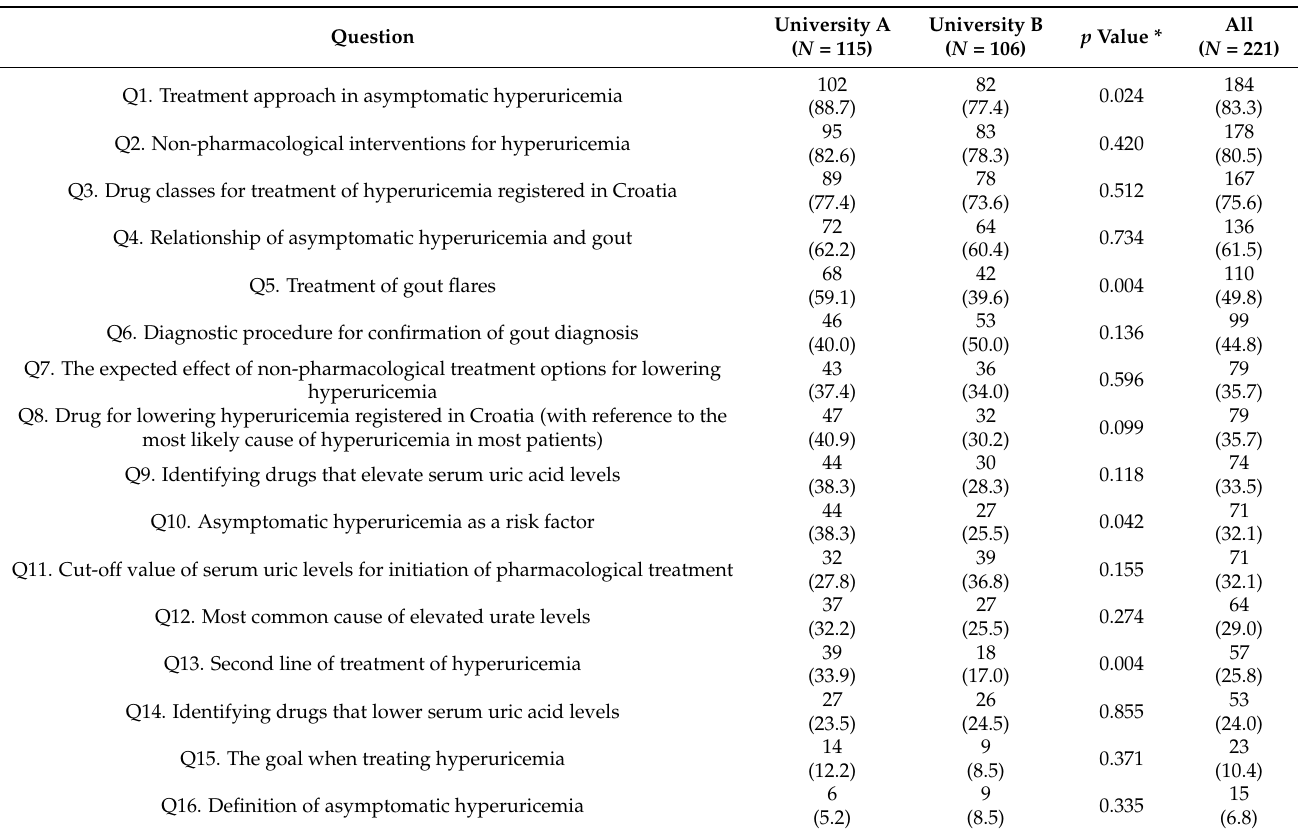
Table 2. Correct answers to knowledge questions relative to students’